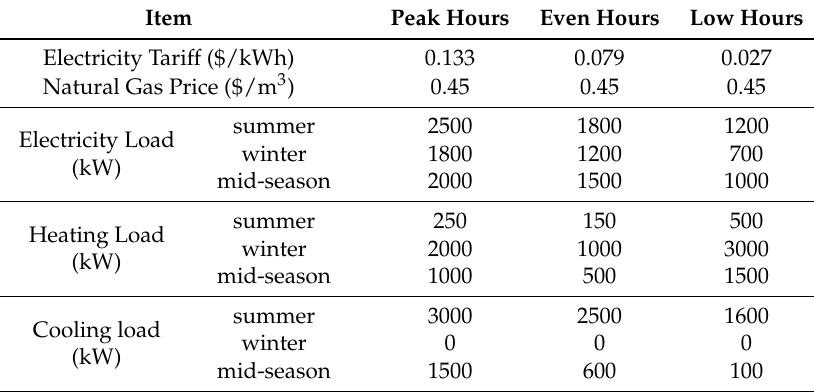
Table 2. Demand and energy price during peak, even and low